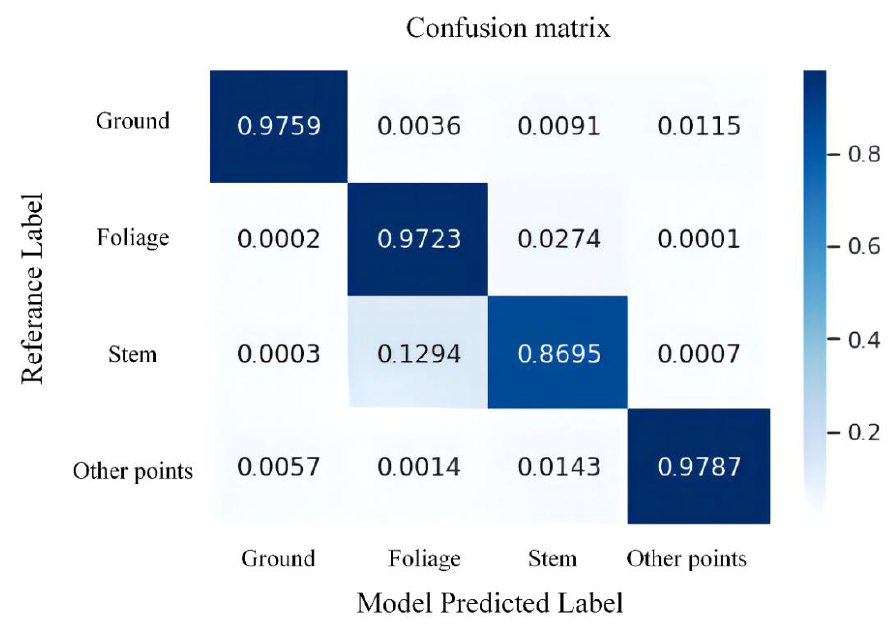
Figure 11. A confusion matrix showing the results of manual labeling compared with semantic segmentation. Table 2. The Recall, Precision, Overall Accuracy, and IoU